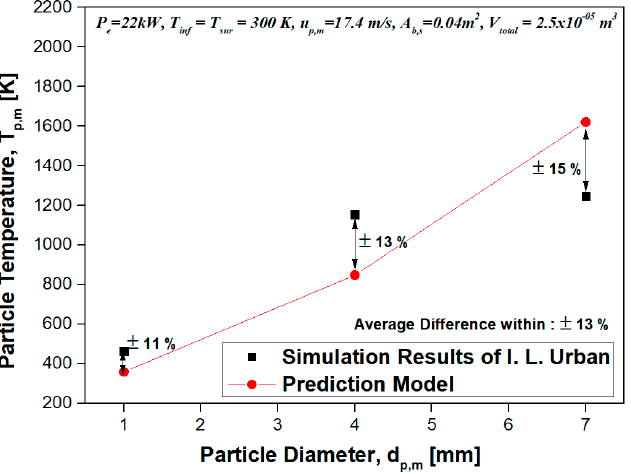
Figure 8. Comparison of the particle temperature of the prediction model with previous results.